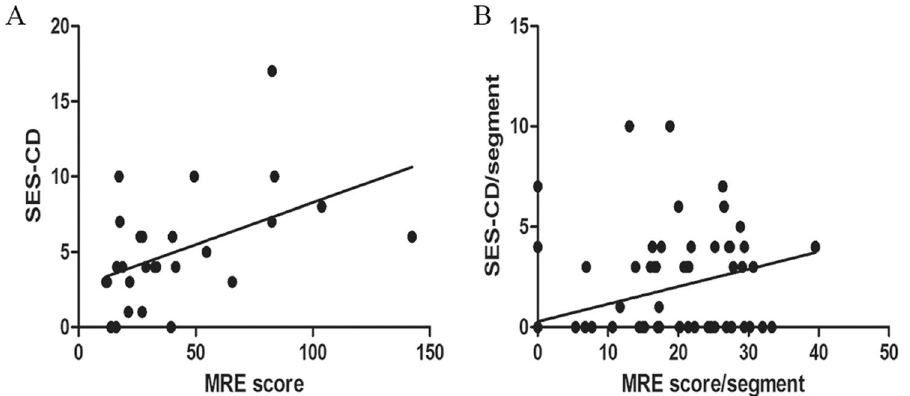
Figure 1. ( A ) Scatterplot demonstrating the correlation between Magnetic Resonance Enterocolonography (MRE) score and the Simple Endoscopic Score for Crohn’s disease (SES-CD). The Spearman rank correlation coefficient was r = 0.527 (P = 0.005, n = 27); ( B ) Scatterplot demonstrating the correlation between the MRE score/ segment and the SES-CD/segment. The Spearman’s rank correlation coefficient was r = 0.590 (P < 0.001, n =